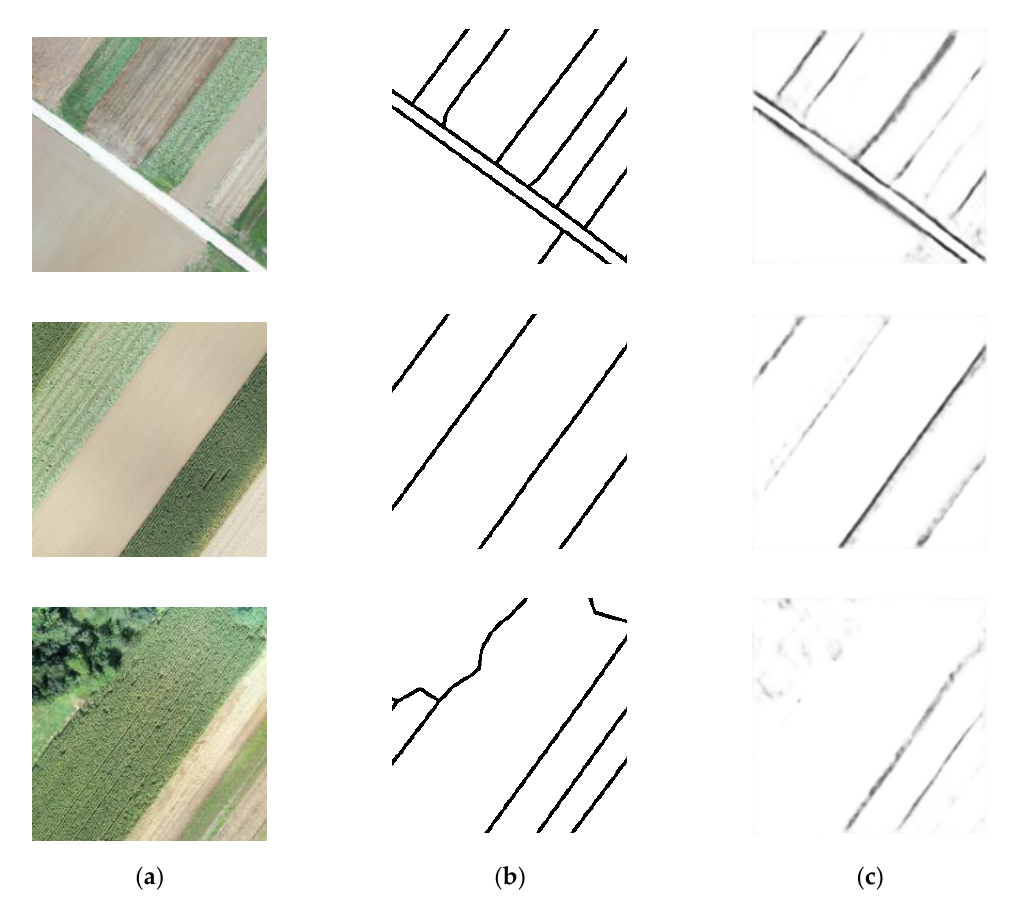
Figure 7. ( a ) Examples of UAV testing tiles; ( b ) label images; ( c ) predicted boundary maps with values 0–1.